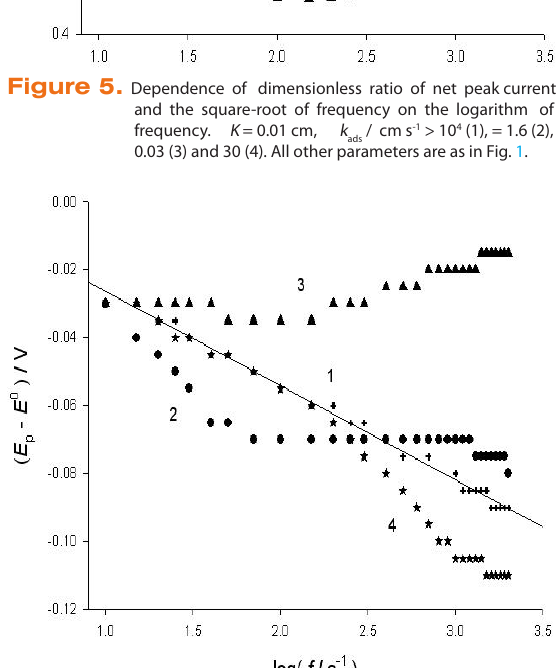
Figure 6. Dependence of the net peak potential on the logarithm of frequency. K = 0.01 cm, k / cm s -1 > 10 4 (1), = 1.6 (2), ads 0.03 (3) and 30 (4). All other parameters are as in Fig. Short lines in the left and right sides of Fig. 2 correspond to dimensionless net peak currents of voltammograms shown in Fig. 1. These results indicate that under